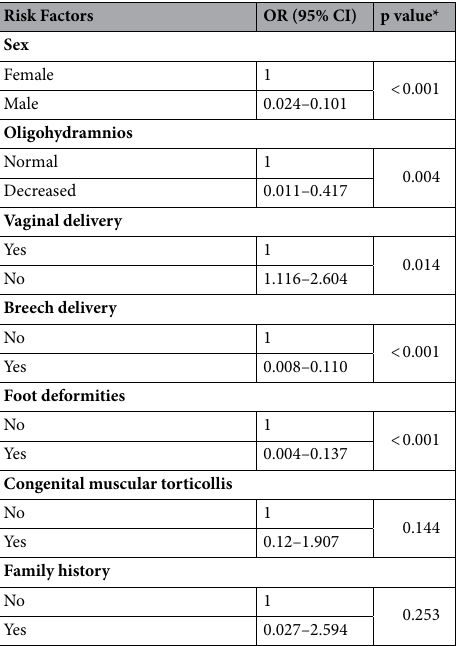
Table 2. Risk factors for the screening of DDH by binary logistic regression analysis. OR odds ratio, CI confidence interval, DDH developmental dysplasia of the hip. *p < 0.05 indicates a significant difference.